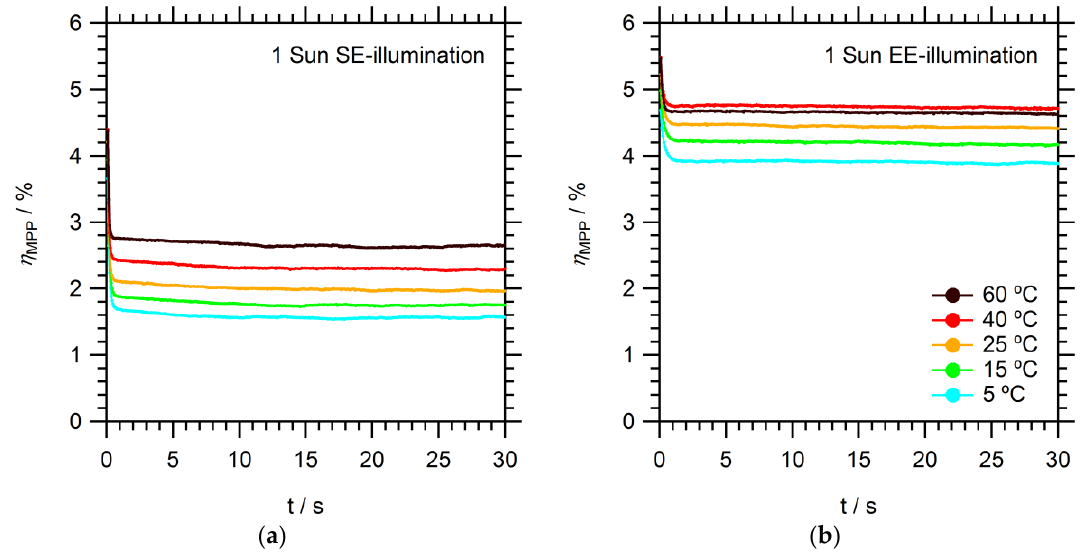
Figure 2. Maximum power point tracking of a DSSC with Co(bpy) 3 /TPAA/MPN electrolyte under ( a ) SE- and ( b ) EE-illumination and at different temperatures.